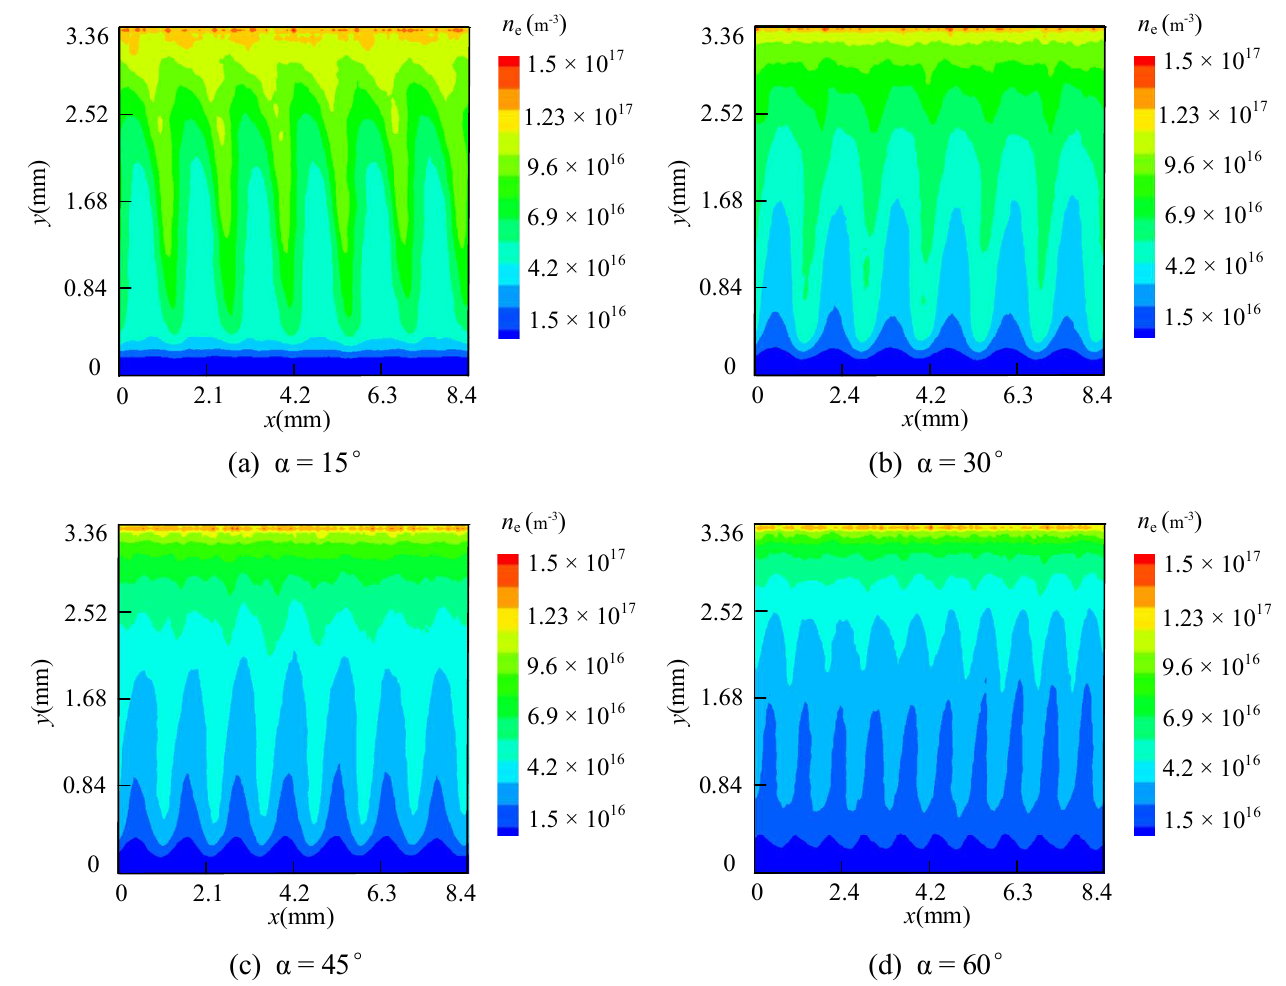
Figure 8. The 2D spatial distribution of electron density with different values of the positive α . Although the axial component of the curved magnetic field does not directly affect the ion distribution, the ion behavior will be affected by the electric potential dominated by the electron motion. When the electric field E is perpendicular to the magnetic field B , most of the ions are captured by the “ion trapping” phenomenon induced by ECDI and move primarily in the azimuthal direction within the channel. When the magnetic field line is convex to the exit plane of HETs, the potential of the wall decreases. The potential gradient along the radial direction allows a greater acceleration of the ions moving toward the wall. Figure 9 shows the ion velocity distribution function for the radial component with different values of the positive α . In order to eliminate the interference of the quasi-neutral region on the particle velocity, all ions within 10 λ De from the upper boundary are neglected in the statistics. It can be seen that as the value of the positive α increases, the average velocity of ions toward the wall increases, and the distribution of the ion velocity becomes more uniform.